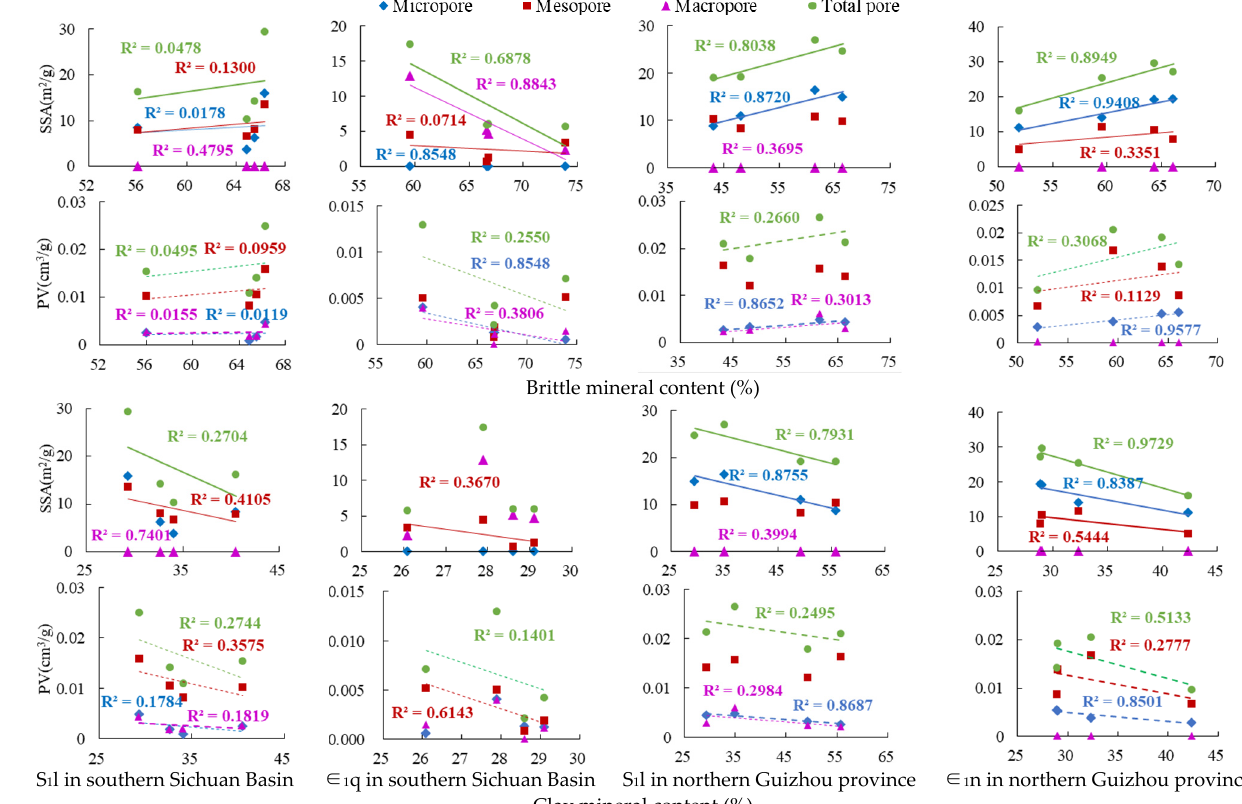
Figure 16. Relationship between mineral content and pore structure parameters of the Lower Paleozoic shale from the upper Yangtze plate.